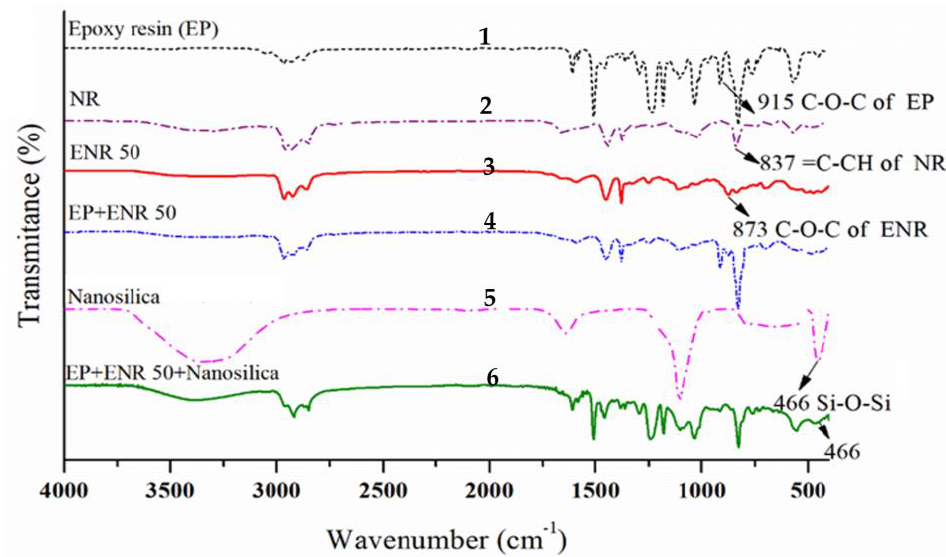
Figure 2. FTIR spectra of nanocomposite and its main raw materials: 1: epoxy resin (EP), 2: natural rubber (NR), 3: Epoxidized Natural Rubber (ENR 50), 4: EP + ENR 50, 5: nanosilica,